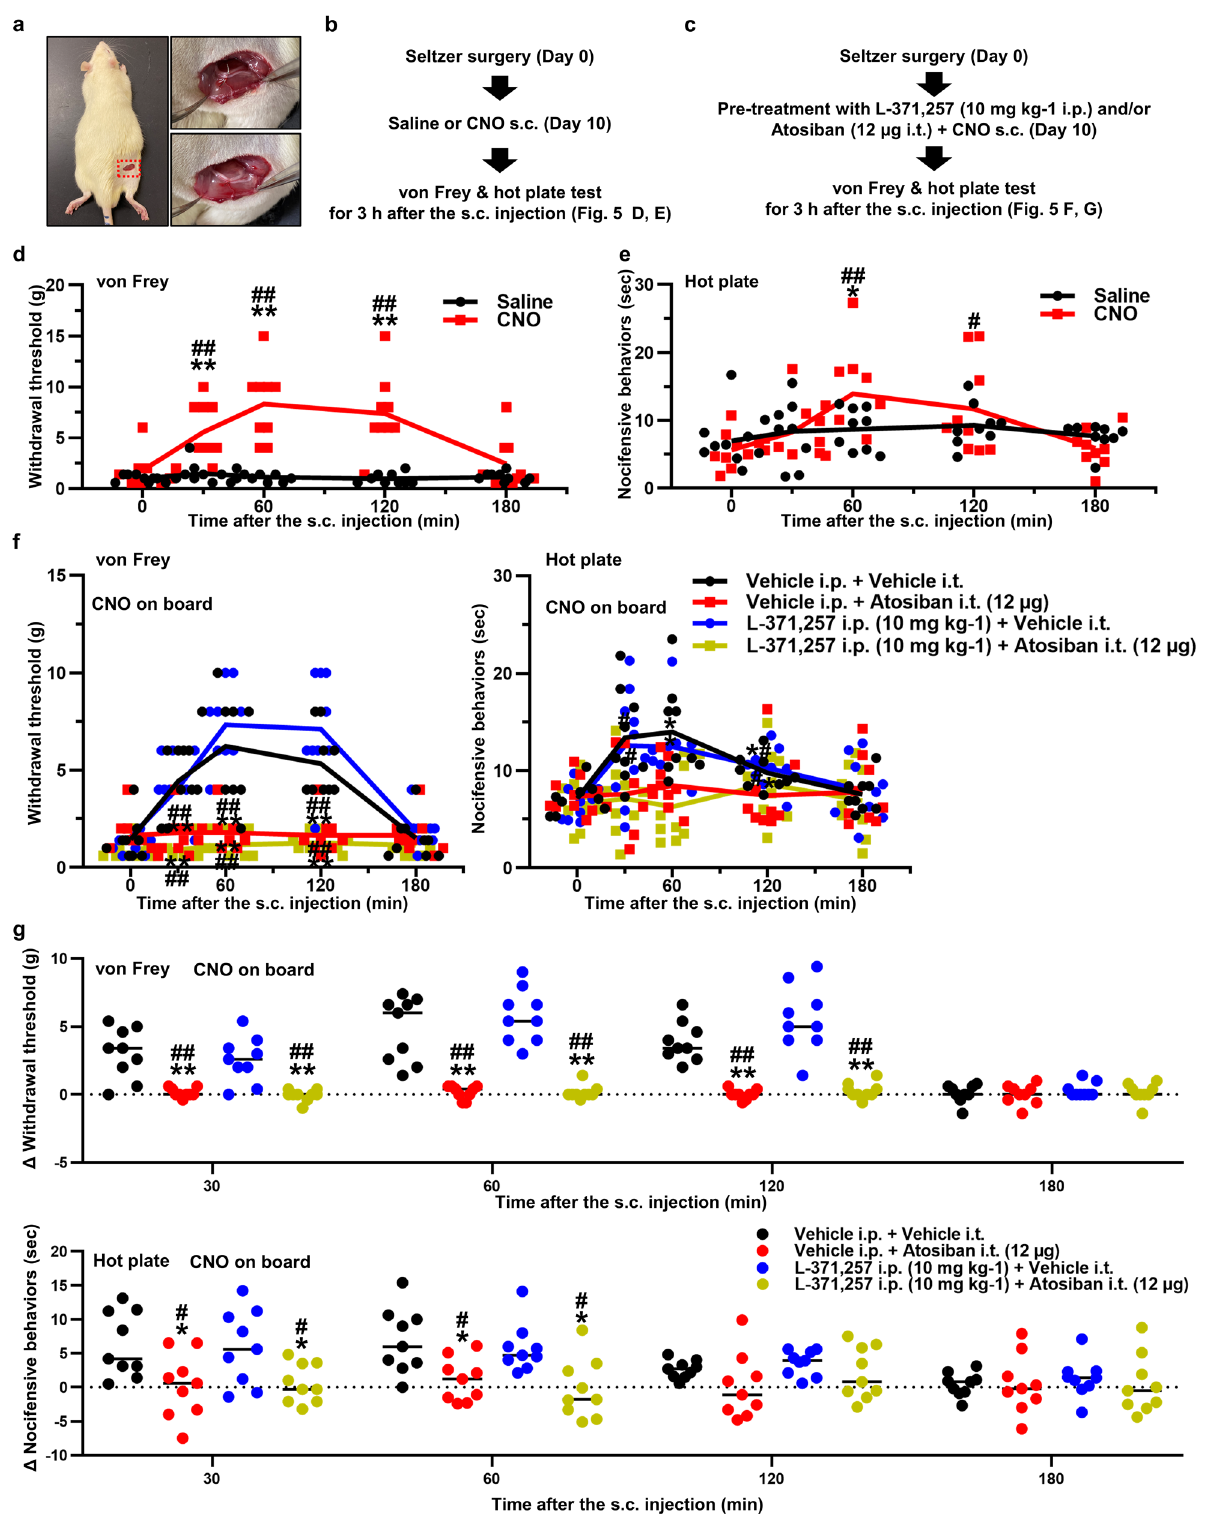
Fig. 6 OT alleviated hyperalgesia in a neuropathic pain model via neuronal pathway. a The Seltzer surgery was performed via dorsal approach. Experimental procedures administering CNO after the Seltzer surgery ( b ) and OT receptor (OTR) antagonist treatment ( c ). Results of the manual von Frey ( d ) and hot plate tests ( e ) after the s.c. injection of Saline or CNO (1 mg kg − 1 ) in the Seltzer model ( n = 9 rats, each). Data are represented as mean ± SEM. ** P < 0.01 vs. Saline at the same time point. # P < 0.05; ## P < 0.01 vs. CNO at 0 min. Results of the manual von Frey ( f ) and hot plate tests ( g ) after the s.c. injection of CNO (1 mg kg − 1 ) pretreatment with L-371,257 dissolved in DMSO [10 mg kg − 1 ] for OTR antagonist i.p., Atosiban dissolved in saline [1 μ g μ L − 1 ] for OTR antagonist i.t., and/or vehicle in the Seltzer model ( n = 9 rats, each). Data are represented as mean ± SEM. ** P < 0.01 vs. Vehicle i.p. + Vehicle i.t., # P < 0.05; ## P < 0.01 vs. OTR antagonist i.p. + Vehicle i.t. at the same time point. See also Supplementary Fig. 7.